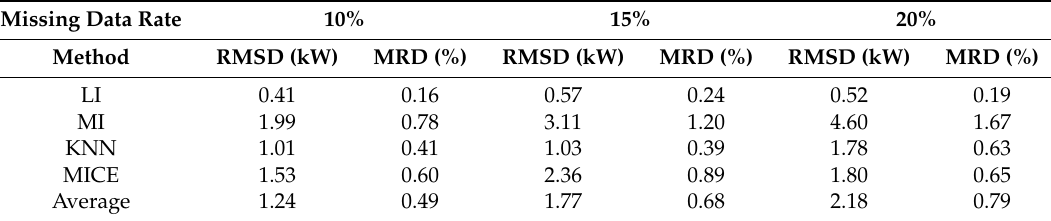
Table 4. Deviation of missing data imputation from the PV forecasting model in June using the test set. Missing Data